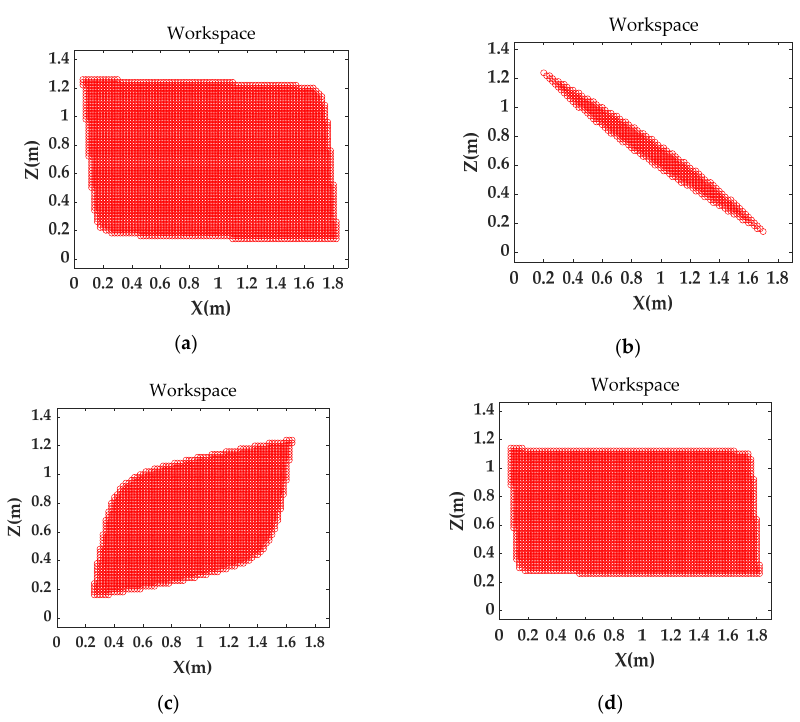
Figure 6. Simulation results when the rotation angle is 3°: ( a ) 1# simulation results; ( b ) 2# simulation results; ( c ) 3# simulation results; ( d ) 4# simulation results.